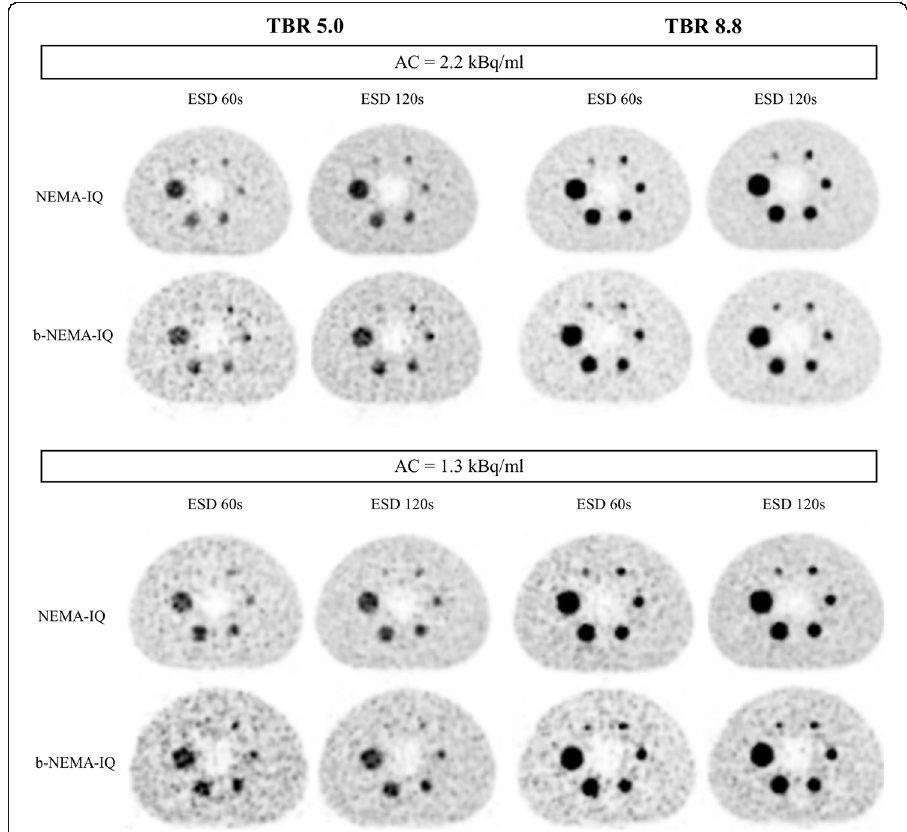
Fig. 6 Equatorial slices of standard spheres of NEMA-IQ and b-NEMA-IQ phantoms for low (5.0) and intermediate (8.8) TBR, two values of AC (1.3 and 2.2 kBq/ml) and two values of ESD (60 and 120 s). The impact of increasing ESD or AC is evident on both the reduction of noise in the background and in the greater visibility of the 10-mm